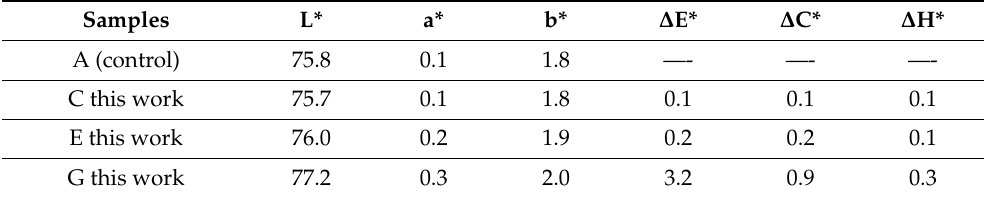
Table 10. Colorimetric L*, a*, b* data, total color difference ∆ E* ( ± 0.2), chroma difference ∆ C* ( ± 0.1), and hue difference ∆ H* ( ± 0.3) for A (the control sample, without treatments); B (treated by capillary adsorption) and C (treated by the brushing).